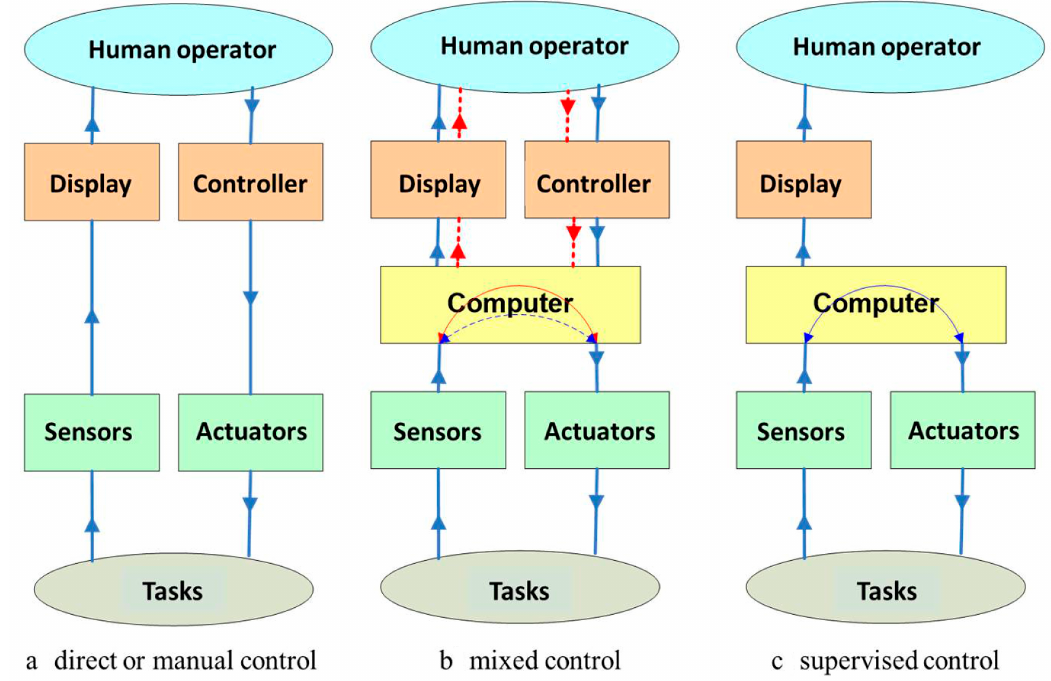
Figure 2. Schematic representation of the three major classes of command-and-control systems of terrestrial robots. For ongoing research, on the use of 6 × 6 terrestrial robots for the purpose of identification, monitoring and intervention in risk areas, we proposed that of the three versions: ( a ) direct or manual control ; ( b ) mixed control ; ( c ) supervised control , to use version ( b